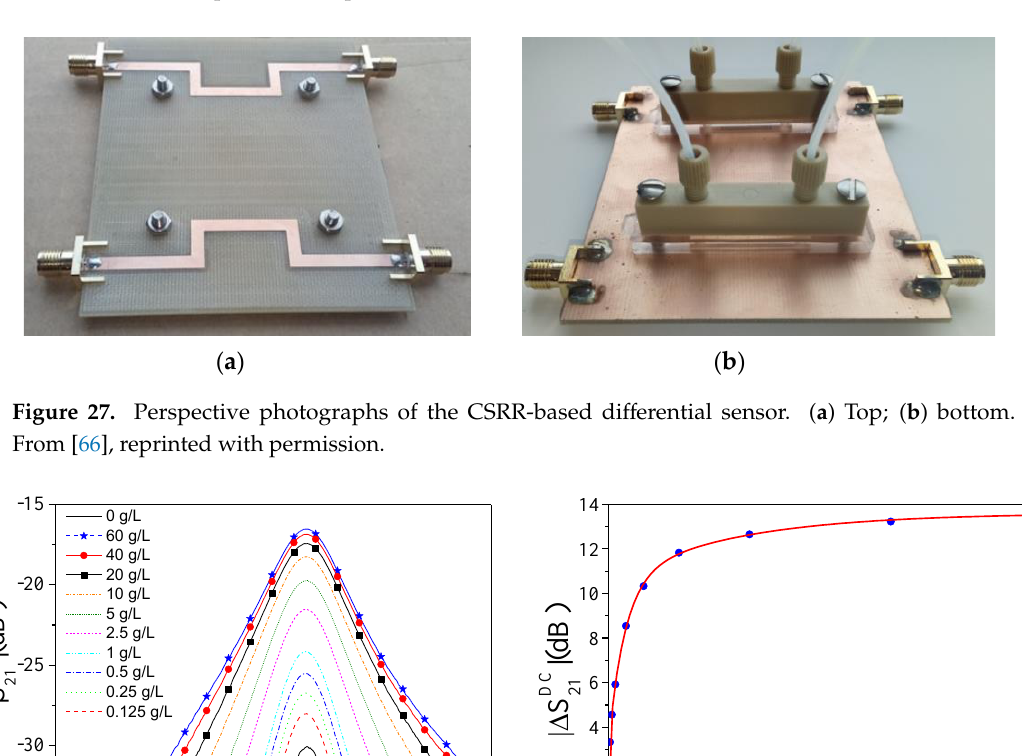
Figure 26. Topology (top view ( a ) and bottom view ( b )) and 3D view ( c ) of the proposed CSRR-based sensor. From [66], reprinted with permission.